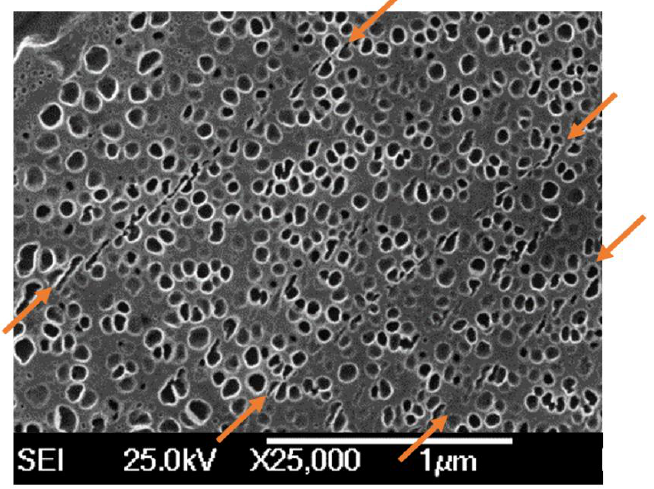
Figure 11. Post-mortem observations on longitudinal cut from crept specimen at 700 °C, fine grains microstructure, 700 °C/800 MPa. Arrows indicate shearing mechanisms.